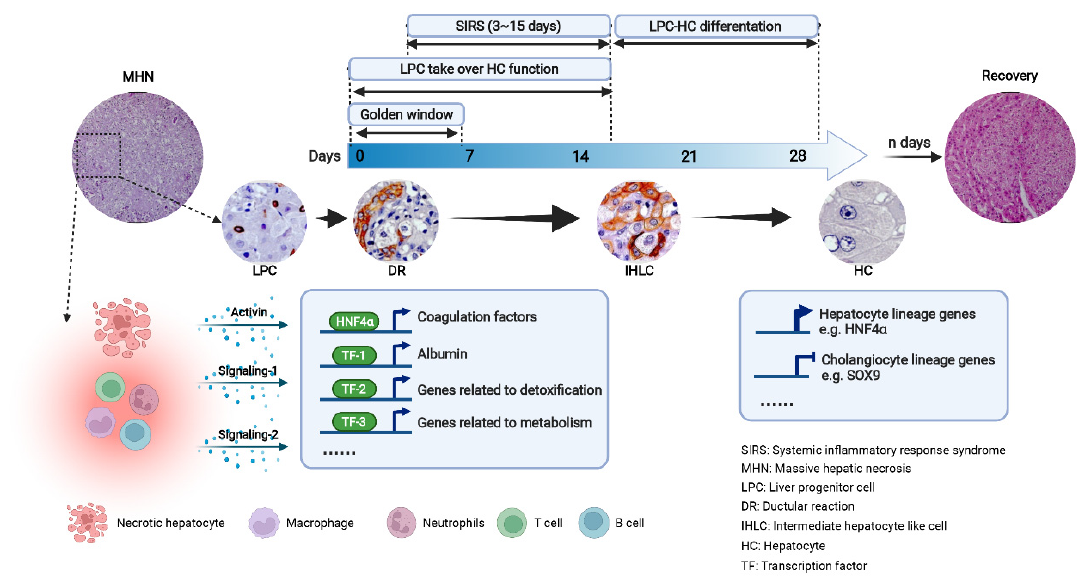
Figure 1. Activation of liver progenitor cells in massive hepatic necrosis-induced acute liver failure. Massive hepatic necrosis and subsequent severe inflammation activates liver progenitor cells (LPC). The first week since the onset of acute decompensation is a gold window for the survival of acute liver failure (ALF). Whether LPC can take over key hepatocyte functions, e.g., initiating the activin-HNF4 α -coagulation factors axis and synthesis of albumin, among other proteins, determines clinical outcome of patients. Systemic inflammatory response syndrome occurs between day 3 and day 15 after disease initiation [12]. The interaction between the inflammatory environment and LPC is crucial for disease progression. After two weeks, intermediate hepatocyte-like cells (IHLC) emerge, suggesting that LPC begin to differentiate towards hepatocytes. Finalizing LPC-to-hepatocyte differentiation is characterized by inactivation of cholangiocyte lineage genes such as SOX9 and intensifying the expression of hepatocyte master genes such as HNF4 α .